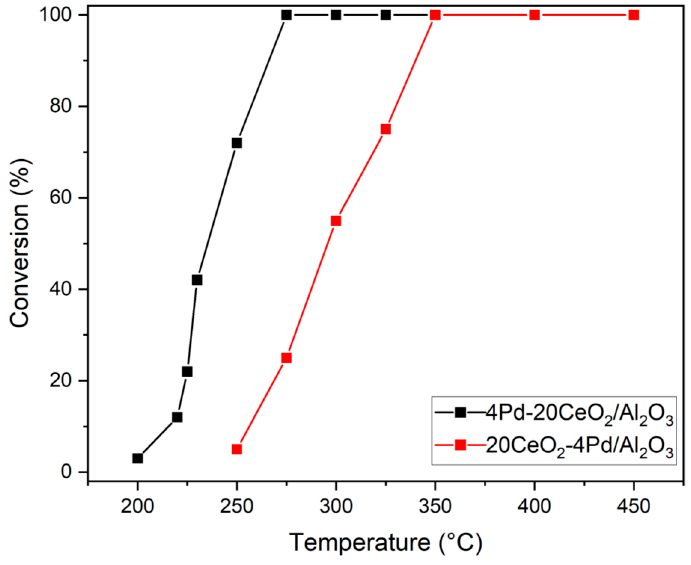
Figure 10. Methane conversion at different temperatures. [GHSV, 45,000 (cc/g.cat) h − 1 ; reaction time at each temperature, 20 min; inlet gas mix composition, 1.0% CH 4 , 4.0% O 2, balance N 2 ].